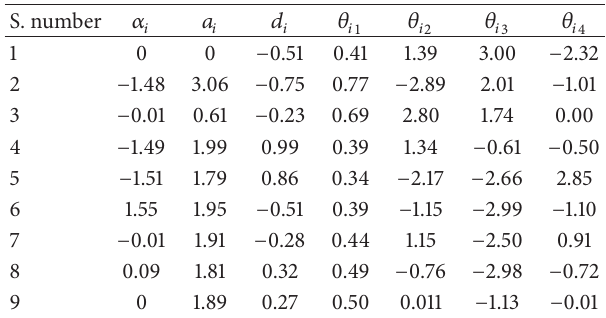
Table 2: Nine-link manipulator design with conventional twist